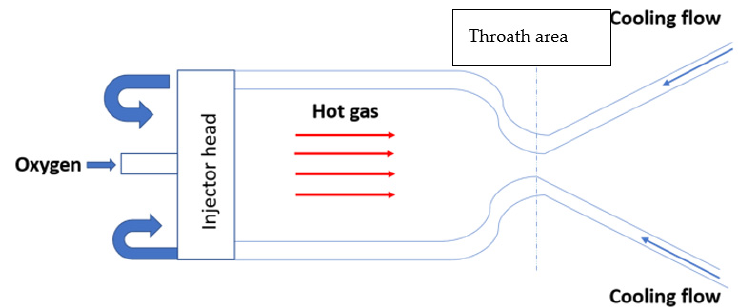
Figure 1. Rocket engine thrust chamber and related functional scheme [5].